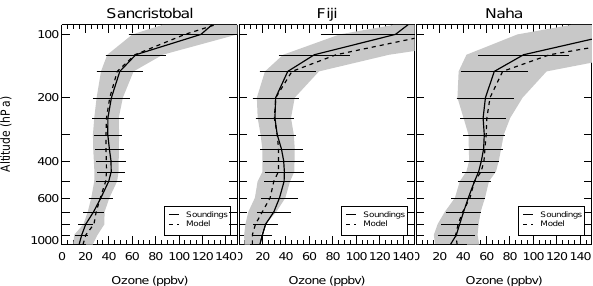
Fig. 3. Comparison of average vertical profiles for ozone as simu- lated by CAM-Chem for the last of a 10-yr run (dashed lines) with observations at three sites (San Cristobal, Galapagos, 1 ◦ S–89 ◦ W; Fiji, 18 ◦ S–178 ◦ E; Naha, Japan, 26 ◦ N–127 ◦ E) of the SHADOZ and WOUDC ozonesonde networks (solid lines). Shaded areas and horizontal bars represent the standard deviation of modelled fields and observations, respectively.